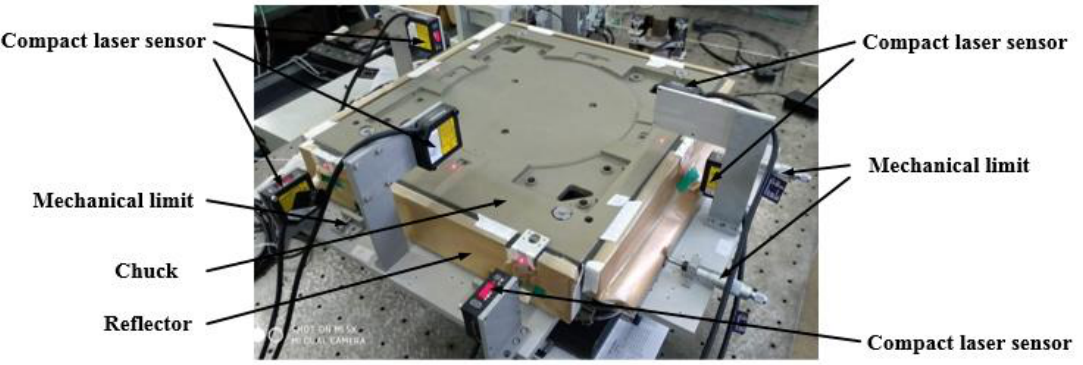
Figure 6. Experiment setups based on compact laser sensors.